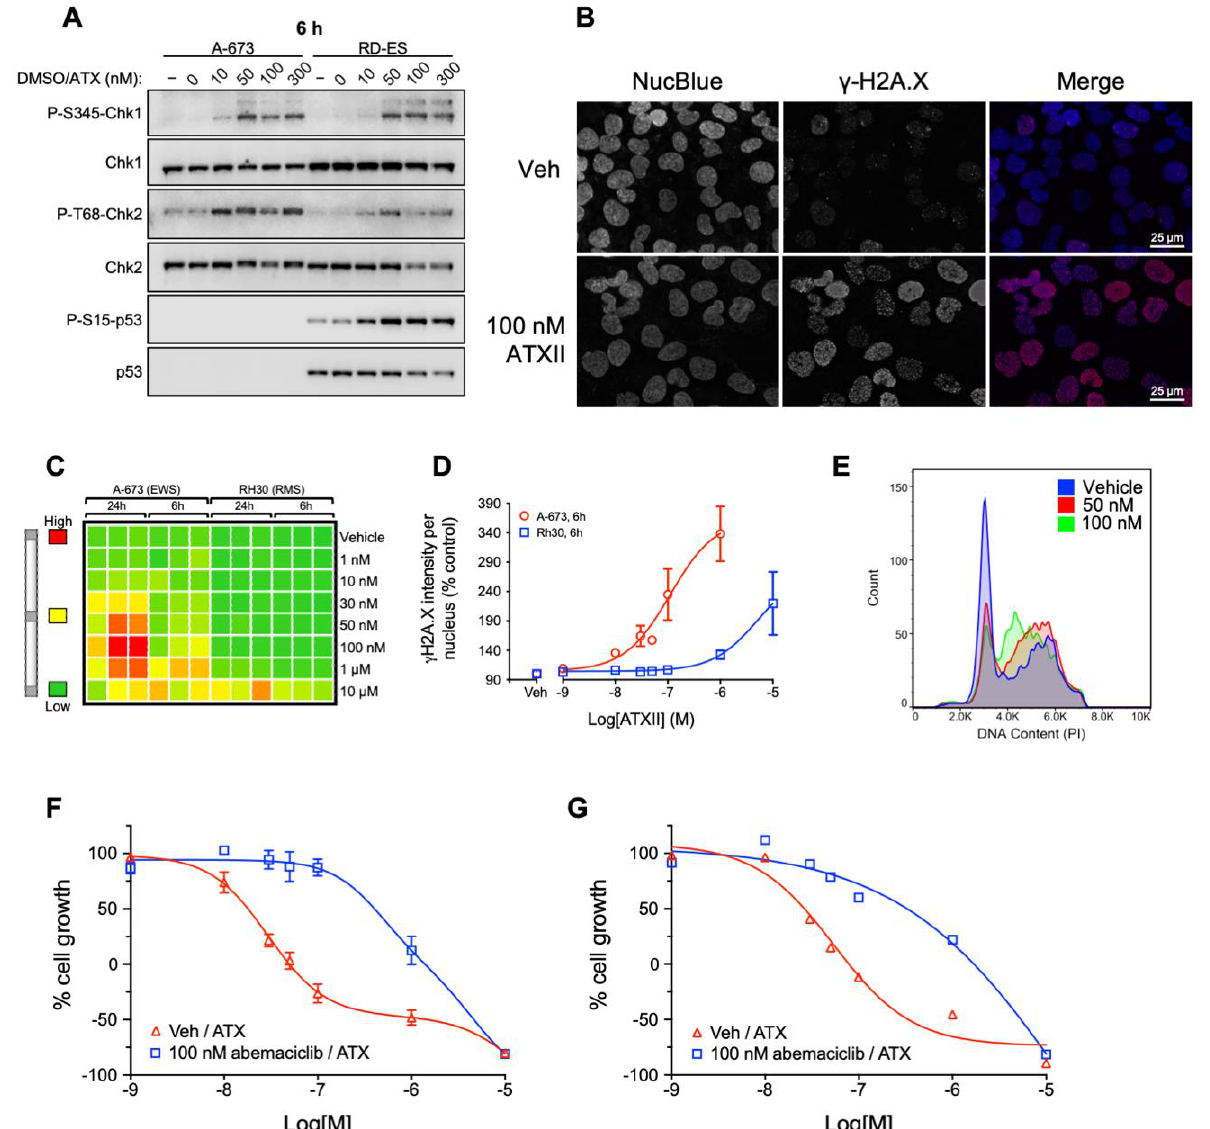
Figure 5. ATXII selectively induces DNA double-strand breaks, inhibits DNA synthesis, and is optimally potent in proliferating cells. ( A ) Immunoblotting for P-S345-Chk1, P-T68-Chk2, and P-S15-p53 in ES cell lines A-673 and RD-ES after a 6-h treatment with ATXII. ( B ) Indirect immunofluorescence microscopy of γ -H2A.X in A-673 cells after an 18-h treatment with ATXII. ( C ) Representative heatmap and ( D ) concentration-response curves for ATXII-induced γ -H2A.X accumulation in A-673 and Rh30 cells. The cells were treated in triplicate for 6 or 24 h with increasing concentrations of ATXII, and γ -H2A.X was measured by automated immunofluorescence imaging. Results represent mean ± SE; n = 2. ( E ) Analysis of cell cycle distribution by flow cytometry. A-673 cells were treated for 24 h with indicated concentrations of ATXII, and the DNA content was determined by PI staining of permeabilized cells. ( F ) Concentration-response curves for ATXII in RD-ES and ( G ) A-673 cells after pretreatment with the CDK4/6 inhibitor abemaciclib for 24 h. Results represent mean ± SE for n = 3 (RD-ES) or n = 1 (A-673) independent experiment(s) with each concentration tested in triplicate.